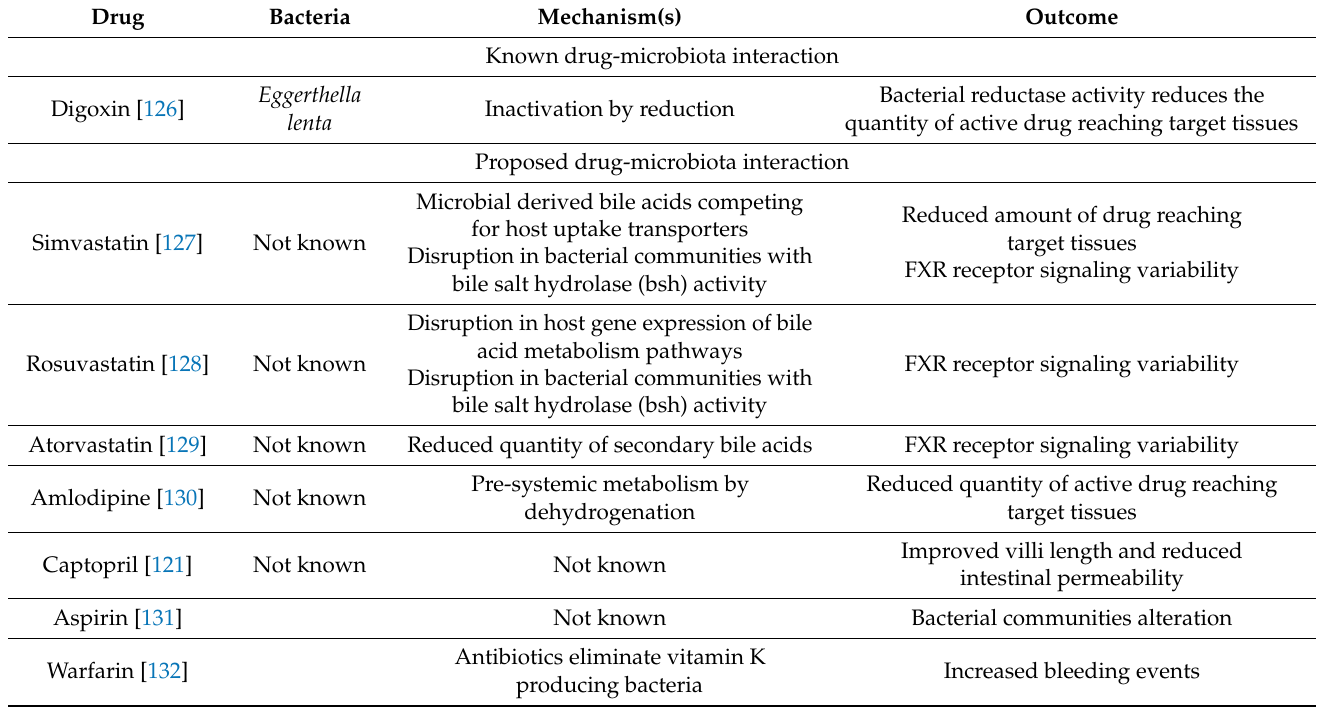
Table 3. Known and proposed mechanisms by which the gut microbiota may influence cardiovascular drug outcomes, adapted from Tuteja et al.